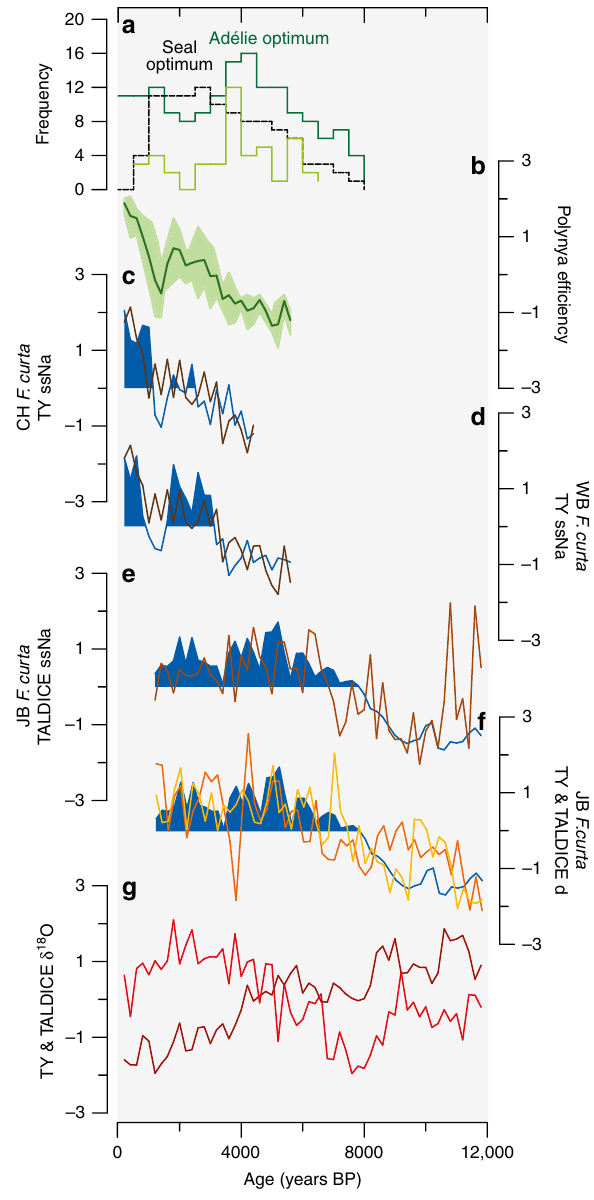
Fig. 6 Holocene WRS sea ice variability in the CSIZ and OSIZ along with polynya ef fi ciency and faunal remains. a Frequency of 14 C-dated faunal remains: Adélie penguins (dark green line), Antarctic silver fi sh (light green line) and elephant seals (black dashed line). b Polynya ef fi ciency, with standard deviation values, obtained from a stacked record of CSIZ F. curta and TY ssNa records. c Fragilariopsis curta relative abundances in WRS_CH (blue line), with blue shading representing heavier CSIZ conditions, compared to TY ssNa 33 (dark brown line) as a coastal sea ice proxy. The correlation coef fi cient ( r ) between the two records is 0.67. d Similar to c but for WRS_WB with r equal to 0.71. e F. curta relative abundances in WRS_JB (blue line), with blue shading representing heavier, more extended OSIZ conditions, compared with TALDICE ssNa (light brown line) as a proxy for pack ice extent; r is 0.49. f F. curta relative abundances in WRS_JB (blue line and blue shading) compared with TY 35 (orange line) and TALDICE (yellow line) deuterium excess ( d ) records as proxies of evaporative conditions at moisture source regions and related to pack ice extent; r between JB and TY is 0.57 while r between JB and TALDICE is 0.77. g TY 34 (dark red line) and TALDICE (light red line) δ 18 O records as proxies of local site temperature variability. All data were resampled on a 200-yr time step and standardized for the considered